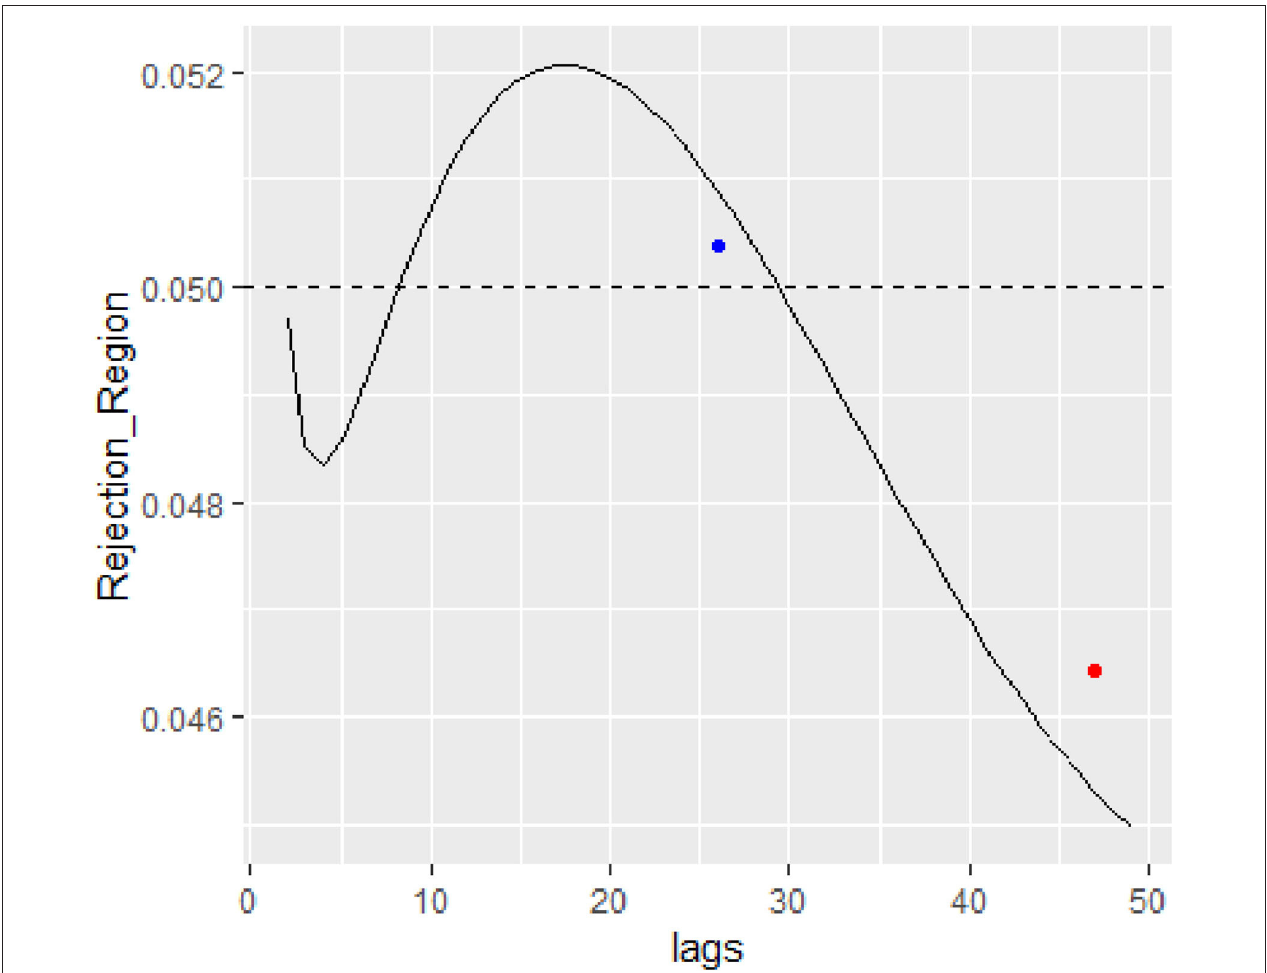
FIGURE 2 | Parametric correction to the rejection region for the real EQT Corporation data is size 50.